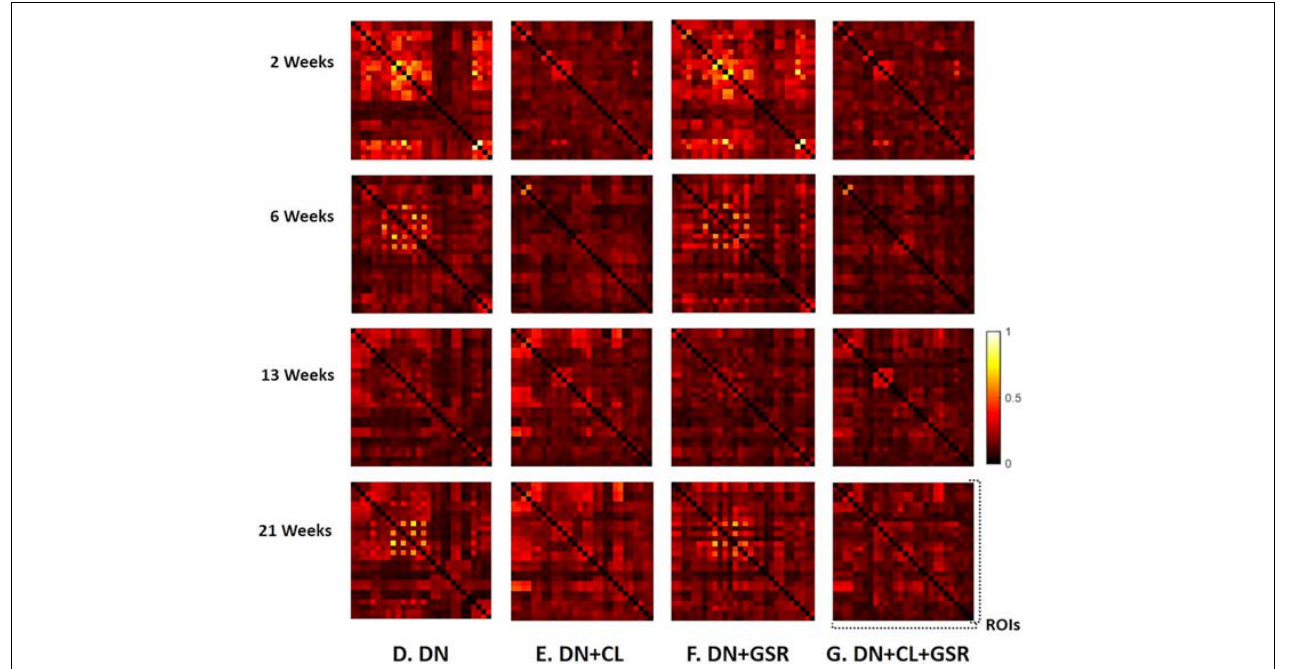
FIGURE 11 | Standard deviation of the Fisher z -transformed correlation coefficient for functional connectivity in the CTL group of Cohort 2 at four different timepoints for four pipelines (D–G) all including DN. Pipeline (G) (DN + CL + GSR) yielded the minimal within-group variability in the homogeneous group of healthy controls for all timepoints, whereas other procedures excluding CL and/or GSR had higher